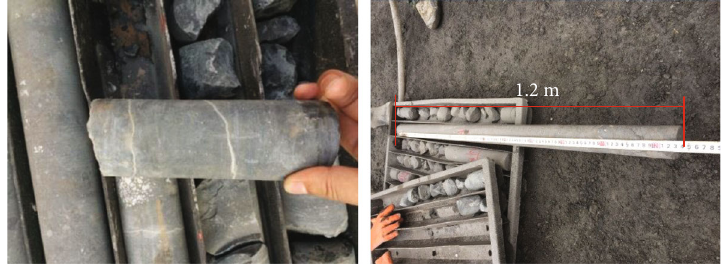
Figure 15: Test hole core sampling.